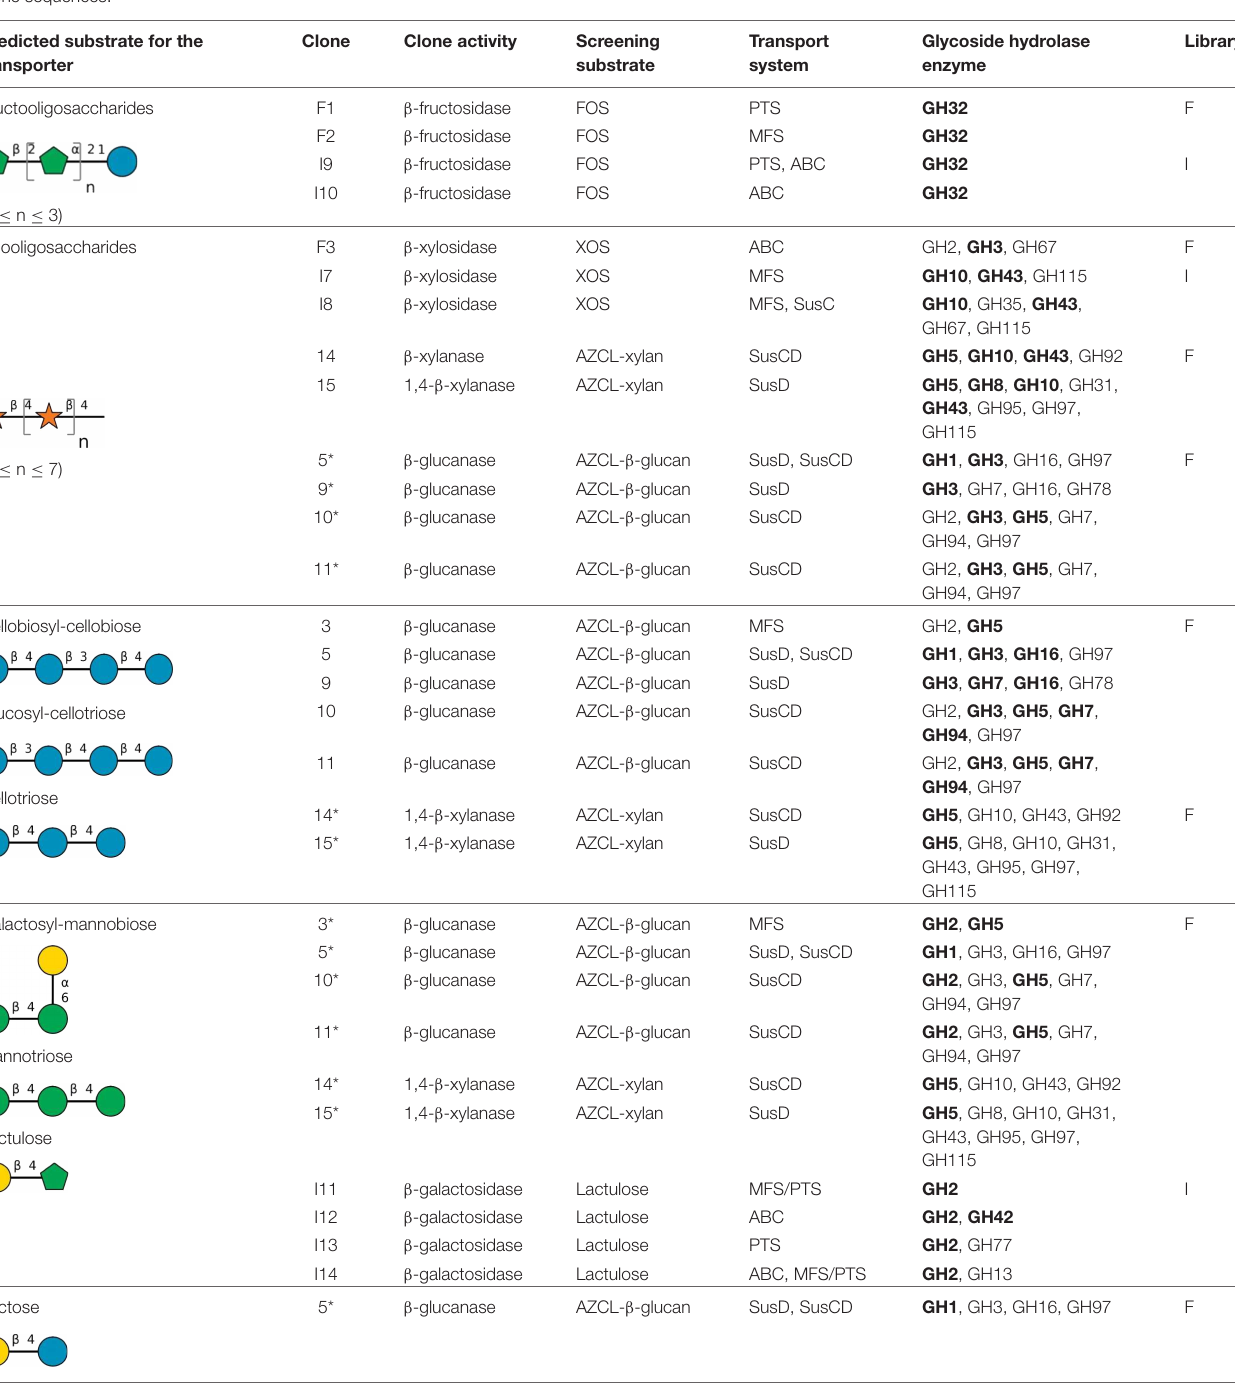
TABLE 1 | Predicted substrate specificity of glycoside transporters of metagenomic clones, and corresponding transporters and CAZyme families identified in the clone sequences. Predicted substrate for the